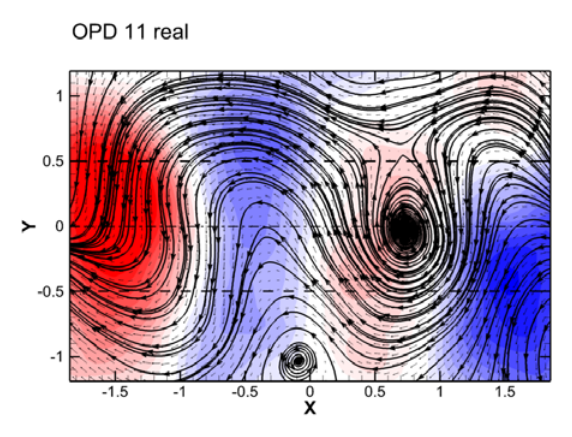
Fig. 14. Real part of the OPD mode 11 topology